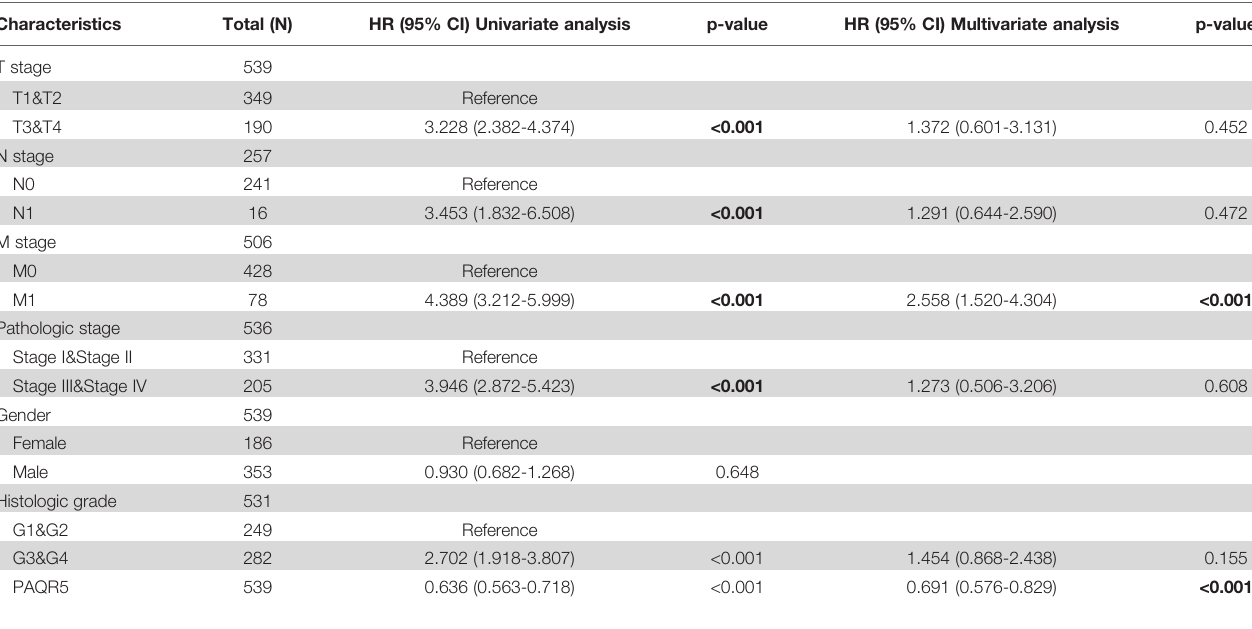
TABLE 2 | Prognostic signi fi cance of PAQR5 and clinicopathological parameters in ccRCC patients. Characteristics Total (N) HR (95% CI) Univariate analysis p-value HR (95% CI) Multivariate analysis